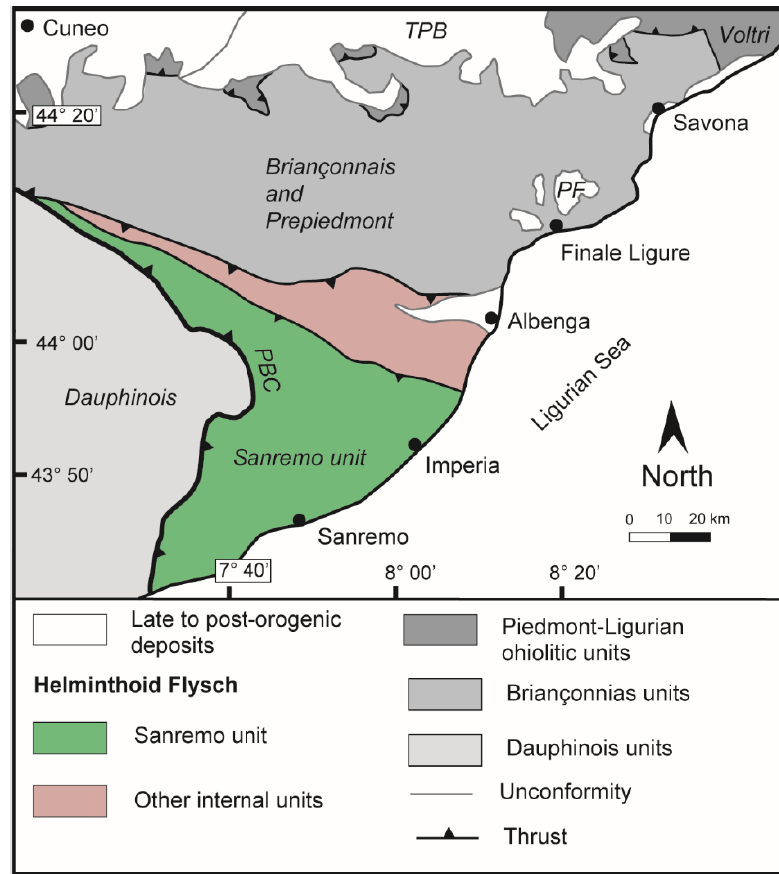
Figure 2. Tectonic setting of the Ligurian Alps [6,8,12], showing the main paleogeographic domains (Piedmont – Ligurian, Prepiedmont, Briançonnais and Dauphinois). The Helminthoid Flysch nappes rest above the Briançonnais – Dauphinois boundary through the Penninic Basal Contact (PBC). PF: Miocene-age Pietra di Finale deposits; Voltri indicates the Voltri Massif of the Piedmont – Ligurian oceanic basement.